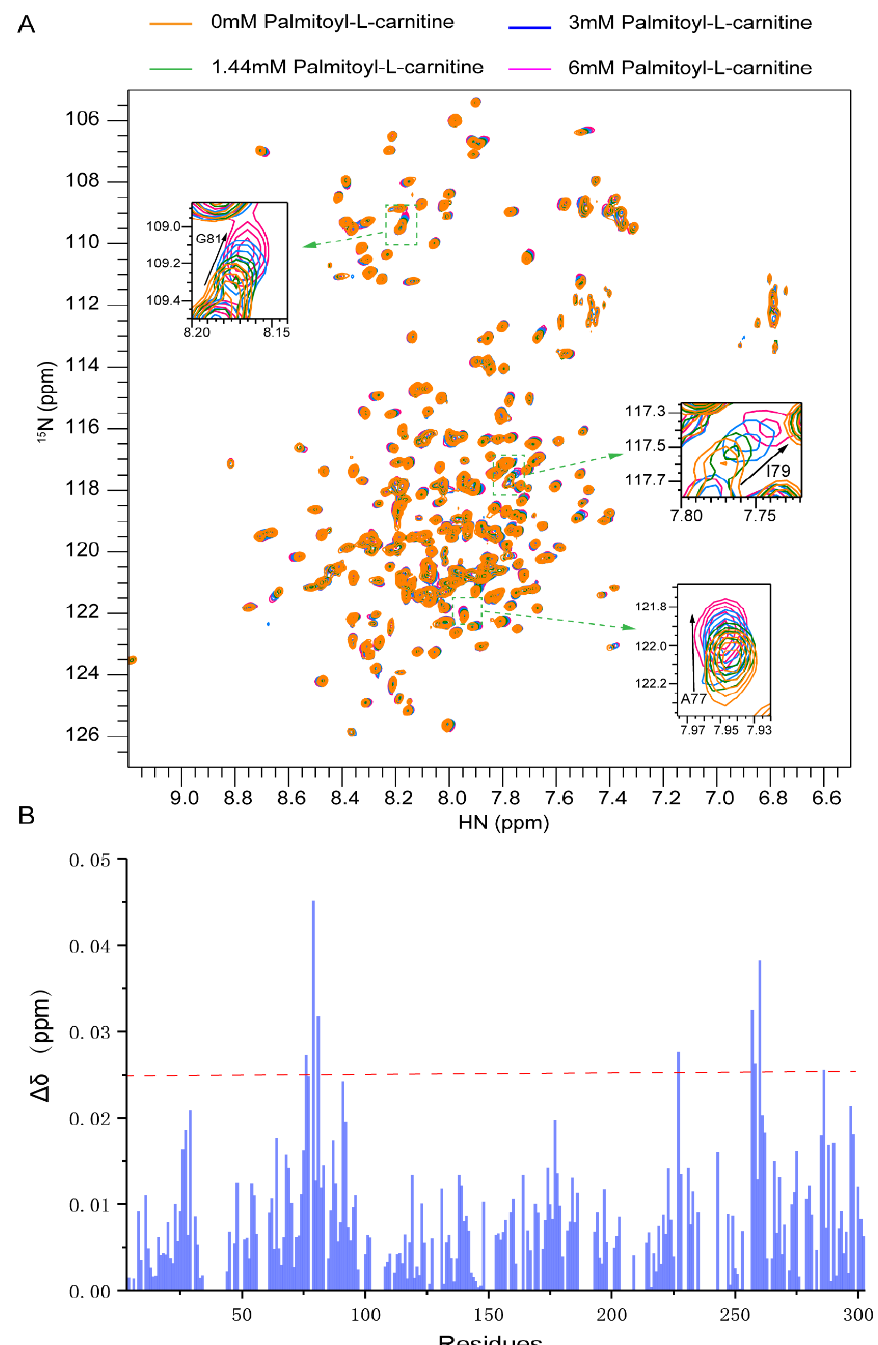
Figure 3. NMR titrations of palmitoyl-L-carnitine into CAC. ( A ) Superimposed 2D 1 H- 15 N TROSY-HSQC spectra with palmitoyl-L-carnitine in multiple concentrations; ( B ) The residue-specific chemical shift changes of the 2D 1 H- 15 N TROSY-HSQC spectra between CAC with and without 6 mM palmitoyl-L-carnitine.